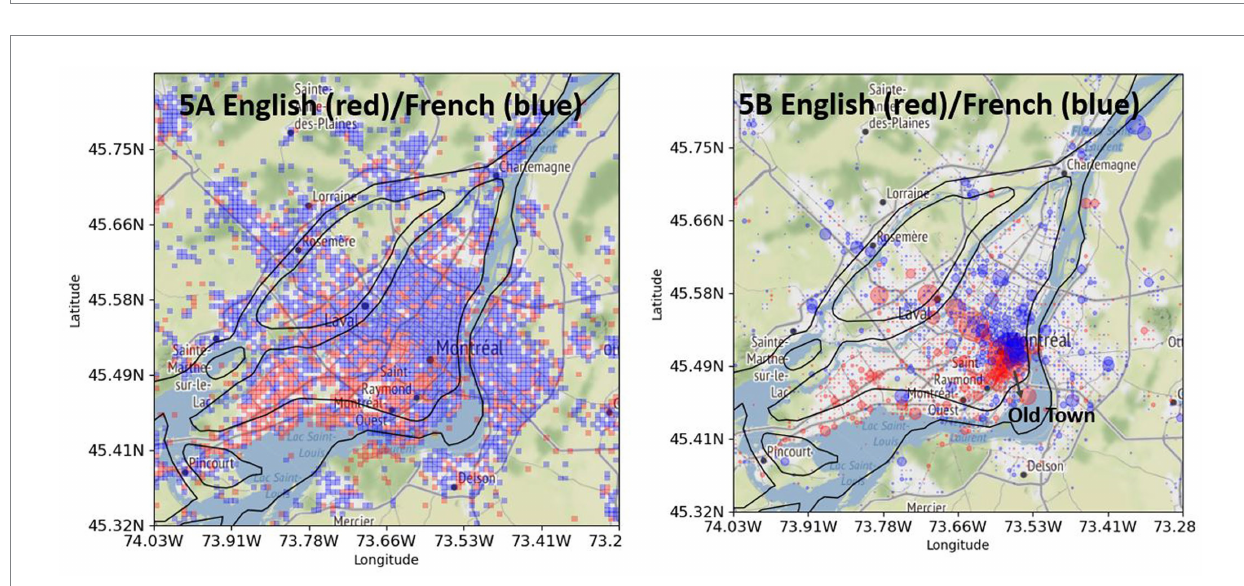
FIGURE 5 English tweets (red) and French tweets (blue) posted by “local” bilingual users in Greater Montreal. ( A , left): without intensity. ( B , right): with intensity. Base map and data from OpenStreetMap and OpenStreetMap Foundation under the Open Database